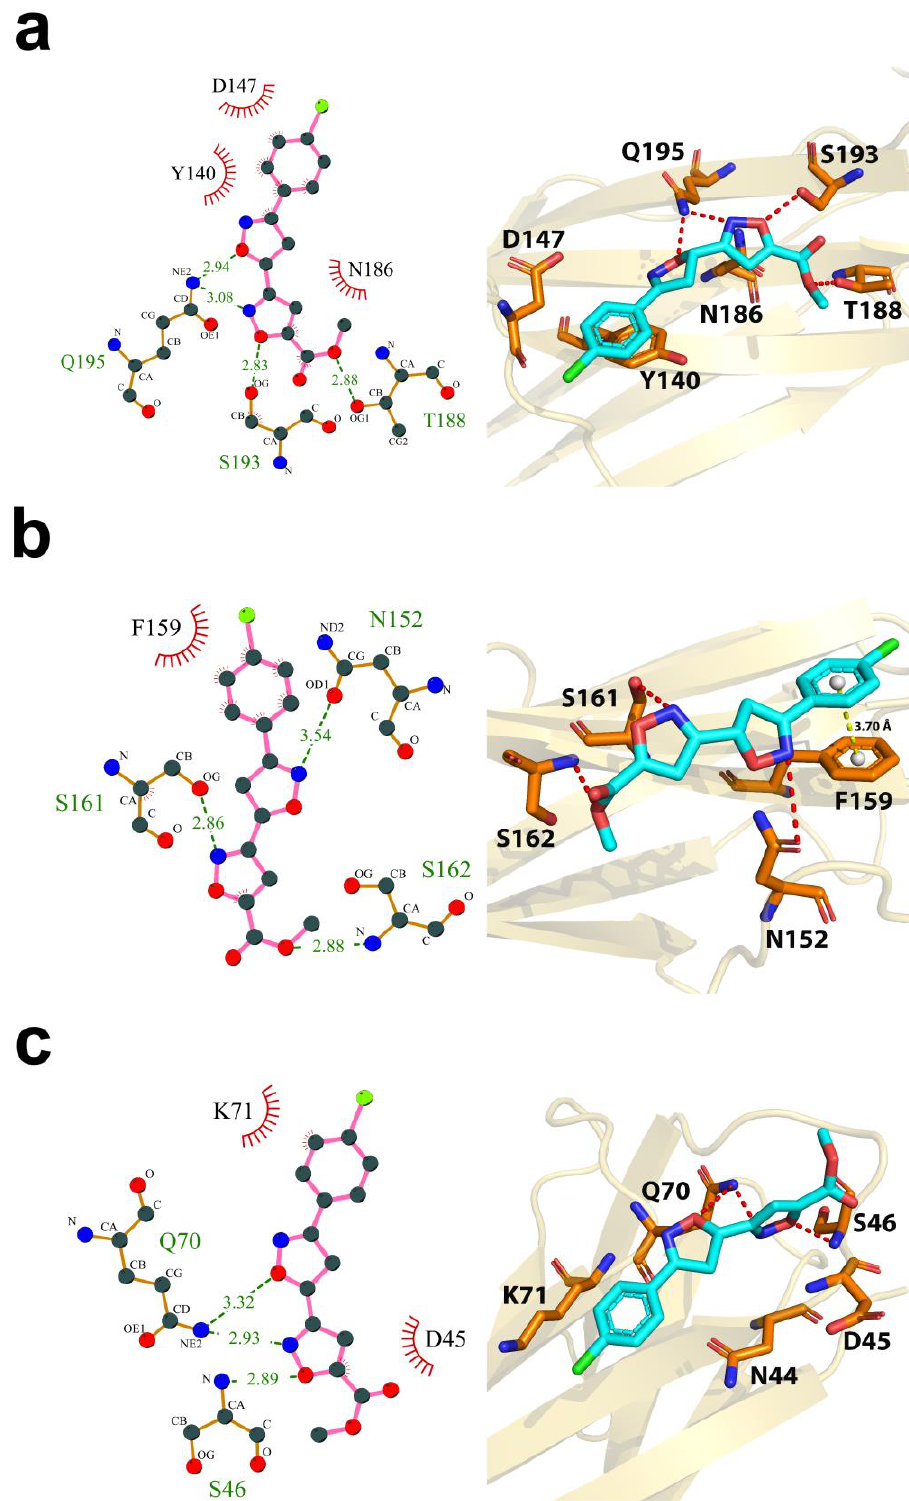
Figure 7. Docking of compound 72 on the glycosylation sites ( a ) N186, ( b ) N152, and ( c ) N44 of CD147. The left panels are LIGPLOT diagrams. Dark slate gray ball, carbon; blue ball, nitrogen; red ball, oxygen; lime green ball, chlorine. Hydrogen bonds are showed as dotted olive green lines. The right panels are binding modes between compound 72 and residues on glycosylation sites. CD147 is shown as ribbons; key residues (orange) and compound 72 (blue) are depicted as sticks; hydrogen bonds are shown as red dashes; the centroids of aromatic rings are represented as gray balls.